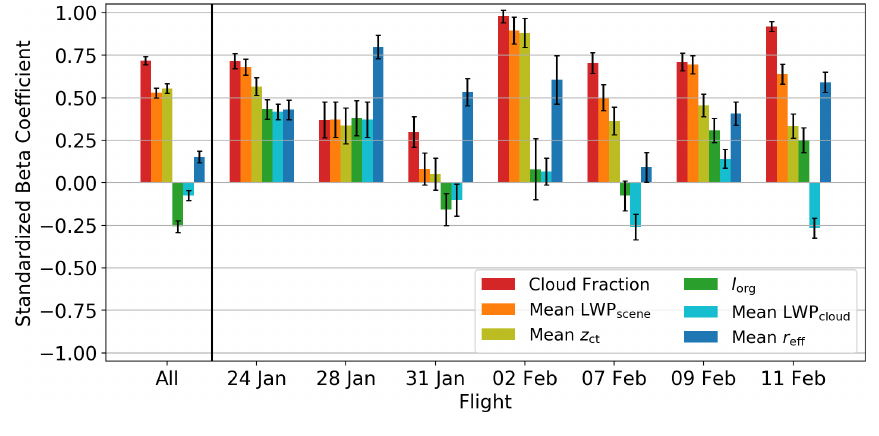
Figure 6. Same as Fig. 5 but for (cid:49)F ter .